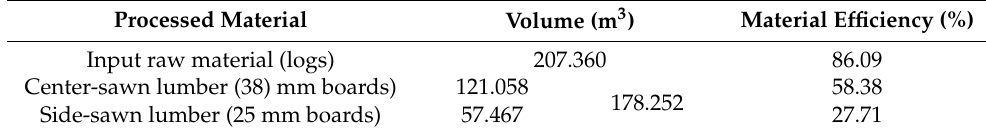
Table 5. The results of the wood sawing process in the “C”